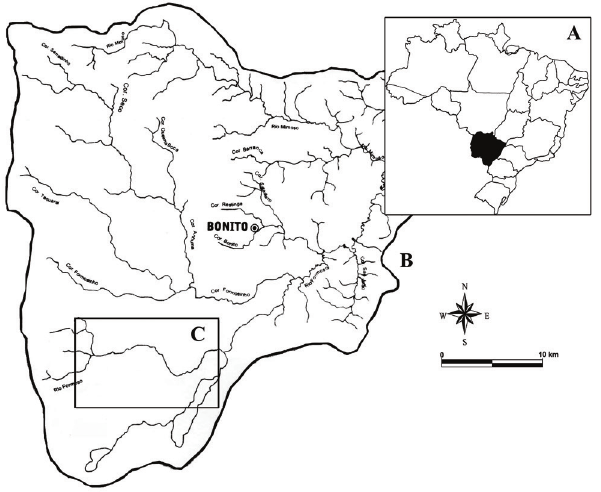
Fig. 1. Map showing the location of the study area: Sucuri River (C), município of Bonito area (B), Brazil (A). Adapted from Miranda & Coutinho (2004).